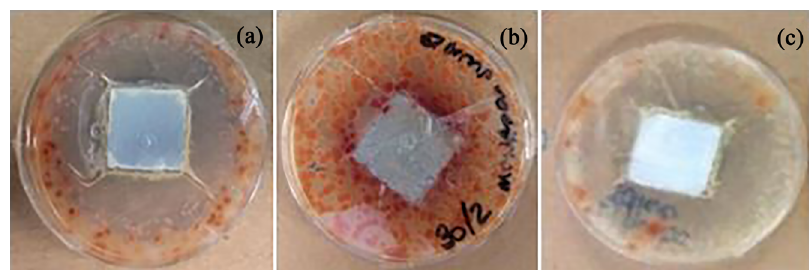
; (b) without TiO and (c) with 5% TiO 2 2